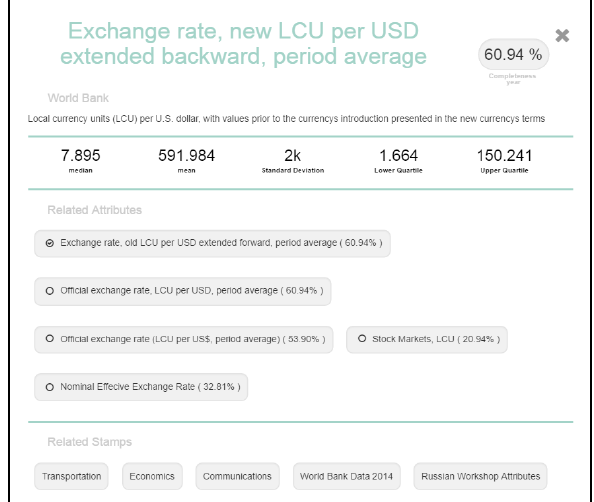
Figure 10. Attribute information